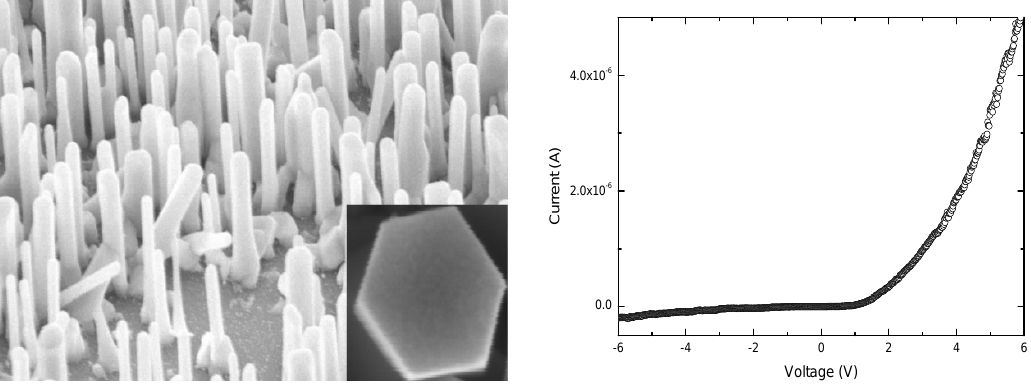
4H-p-SiC epitaxial layer. (Right) Typical room temperature I-V characteristics